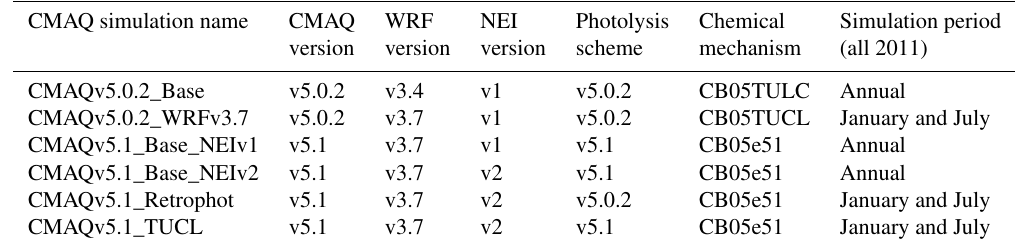
Table 2. Description of the CMAQ model simulations